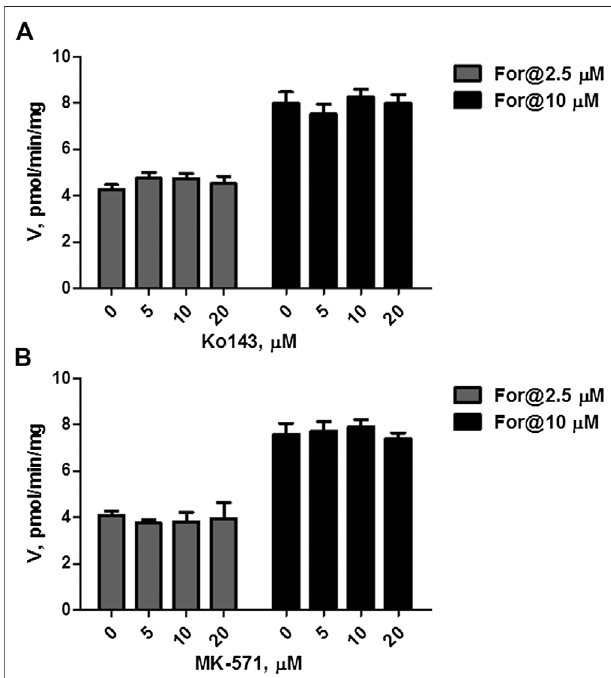
FIGURE 6 | Effects of chemical inhibitors on formononetin (2.5 and 10 μ M) sulfonation in HEK-SULT1A3 cell lysate. (A) Effects of Ko143 on formononetin sulfonation. (B) Effects of MK-571 on formononetin sulfonation. Each data point was shown as mean ± SD (n (cid:1) 3).